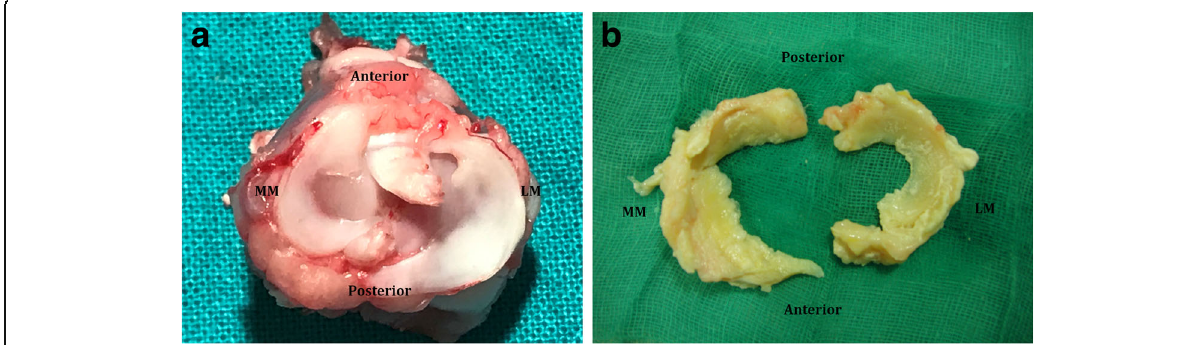
Fig. 1 a Right knee joint from a healthy rabbit. b Human menisci retrieved from an osteoarthritic left knee. MM: medial meniscus; LM: lateral